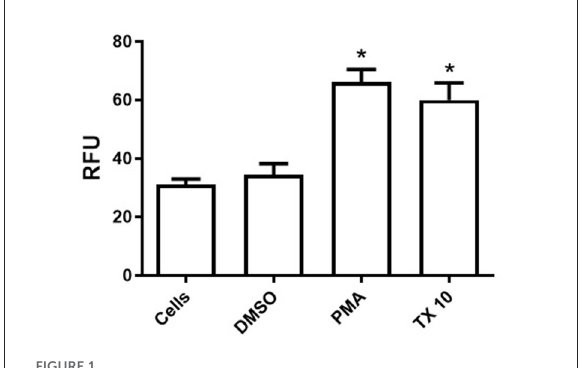
FIGURE1 Tamoxifen (TX) triggers the release of cellular free-DNA (cf-DNA) from peripheral blood neutrophils of adult healthy horses. NETosis was quantified by cellular free-DNA measured in the supernatants of fresh-blood isolated neutrophils in the presence or absence of stimuli by spectrofluorometry. Unstimulated control cells (HBSS) and cells treated with DMSO (0.1%), PMA (200nM) and TX (10 µ M) were evaluated. Data is presented as means ± standard deviation (SD). RFU, relative fluorescence units; * p < 0.05; n =